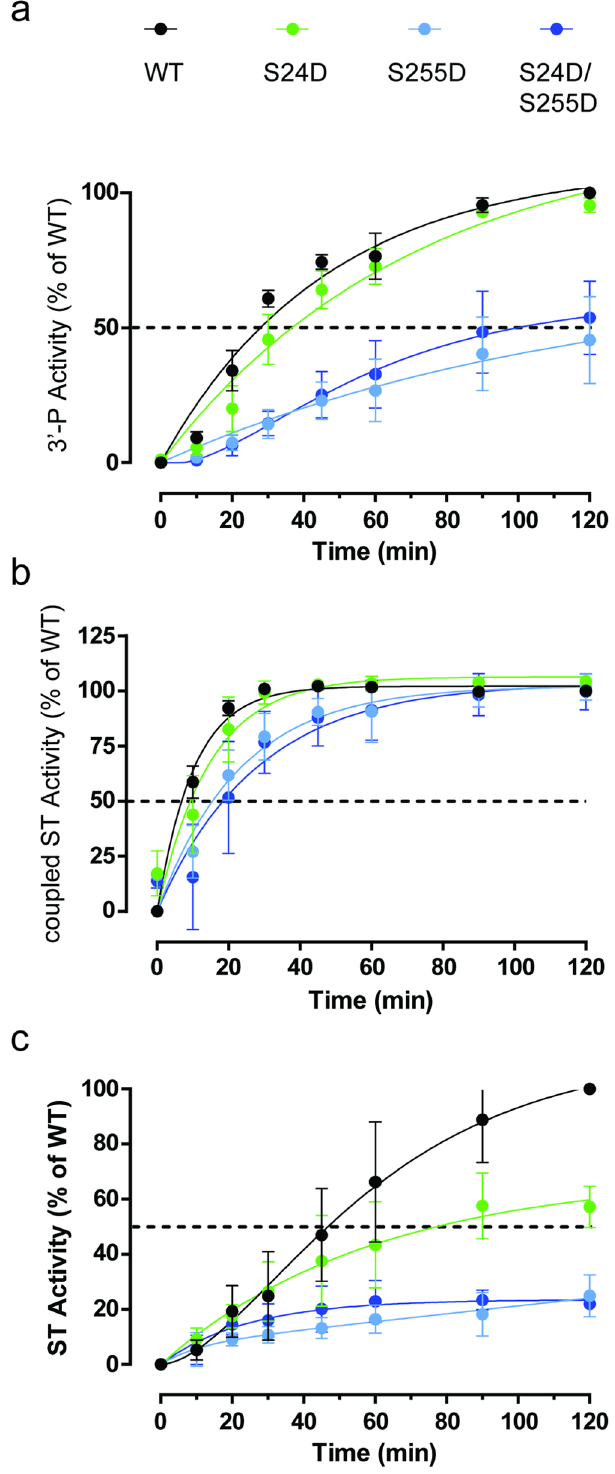
Figure 8. Effect of mutations on HIV-1 IN in vitro activity. Time course experiments were performed to monitor the 3 ′ -P activity ( a ), the resulting ST activity (coupled ST, panel b) and the ST independently of 3 ′ -P (uncoupled ST, panel c). After separation on acrylamide gel and autoradiography, the products were quantified and normalized to the level of the WT enzyme